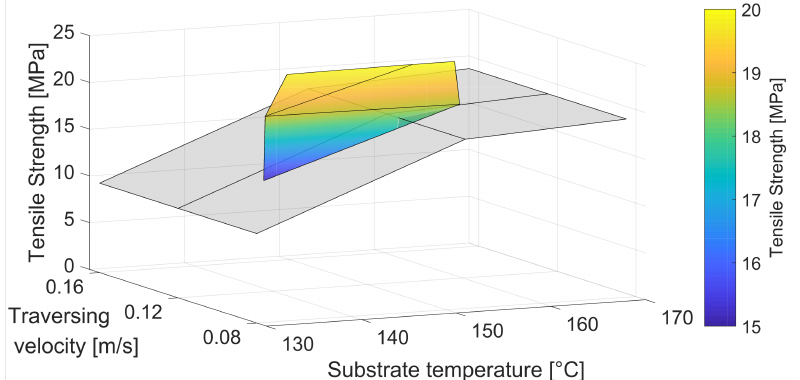
Figure 7. Tensile strength of the cooled specimens at 100 mm cooling distance in the transverse direction with the reference tensile strength for uncooled specimens at the final substrate tempera- ture (gray).